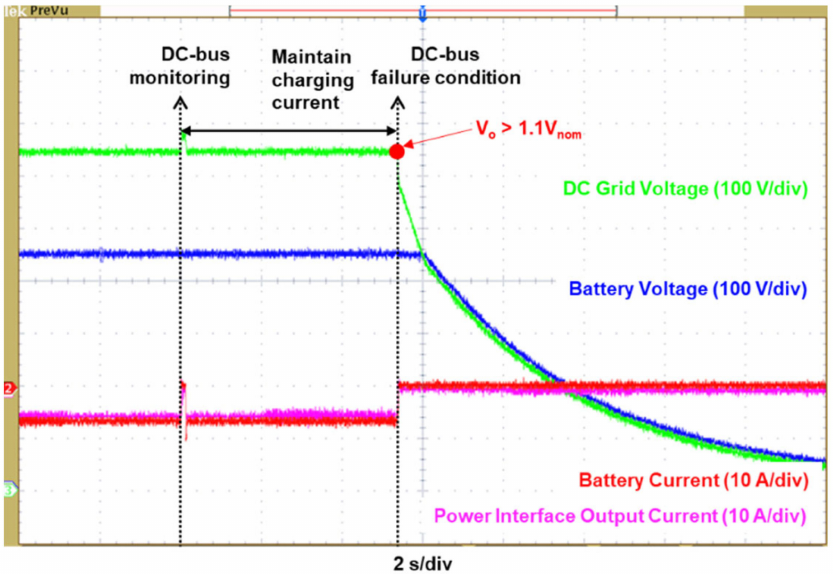
Figure 20. Fault response of proposed voltage regulation algorithm in discharging